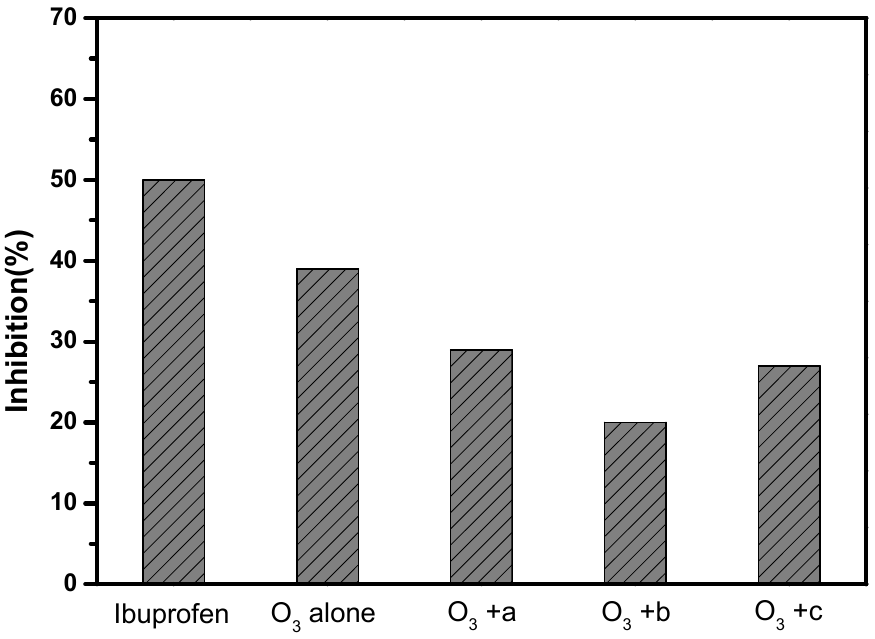
Figure 7. Toxicity analysis of catalysts before and after degradation of ibuprofen: (a) γ -Al 2 O 3 /TiO 2 / γ - Fe 2 O 3 (1:0.5:1); (b) γ -Al 2 O 3 /TiO 2 / γ -Fe 2 O 3 (1:1:1); (c) γ -Al 2 O 3 /TiO 2 / γ -Fe 2 O 3 (1:2:1). In order to further understand which intermediates produced by ozonation alone may cause secondary pollution to the water environment, liquid mass spectrometry was used to test the solution of ibuprofen oxidized by ozonation alone, and the results are shown in Figure 8. Figure 8A shows the mass-to-charge ratio of ibuprofen, and its m / z value is 205.04 ([M-H]-). After ozonation treatment, the main three substances were ana- lyzed, as shown in Figure 8B,C. Their mass-to-charge ratios are 219.28 ([M-H]-), 163.04 ([M-H]-), and 161.23 ([M-H]-), respectively. The substances that may be formed are 1,4- propanal phenylacetic acid, 1,4-acetaldehyde benzoic acid, and p-phenylacetaldehyde. It can be concluded that in the system using ozone alone, some of the ibuprofen molecules would be oxidized to form 1, 4-propanal phenylacetic acid, which would then be further oxidized to form 1,4-acetaldehyde benzoic acid and p-phenylacetaldehyde. The formation of these intermediates may lead to changes in toxicity in the water. Possible degradation paths are shown in Figure S3.